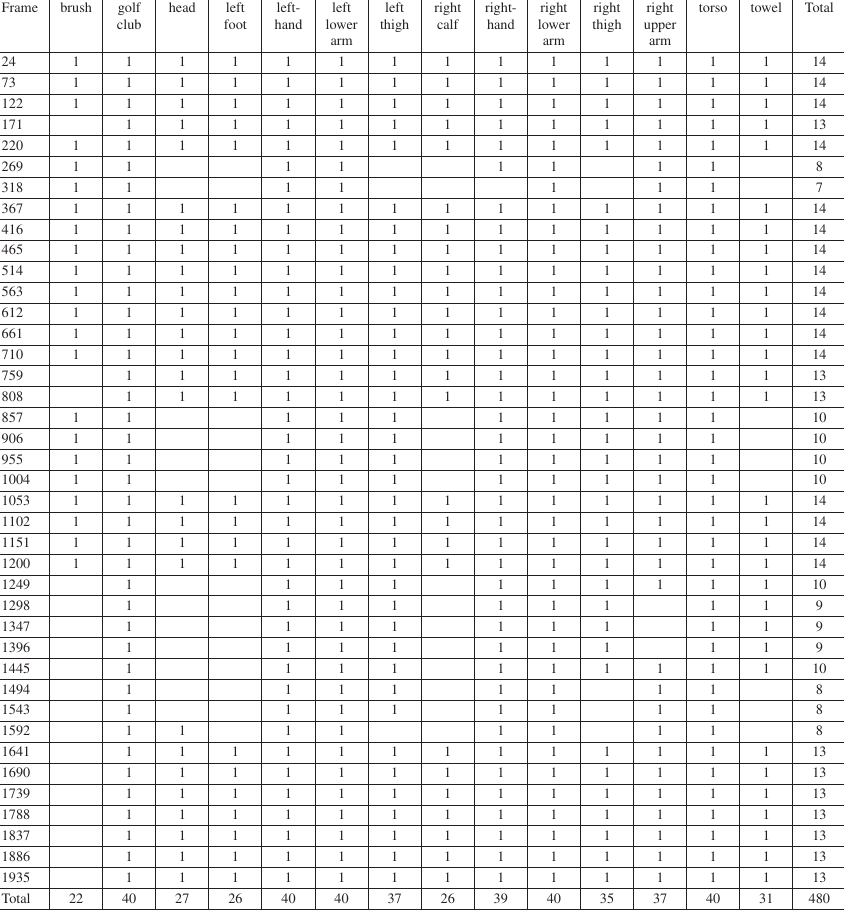
Table 4. Ground truth of the parts that are visible in each frame of the second